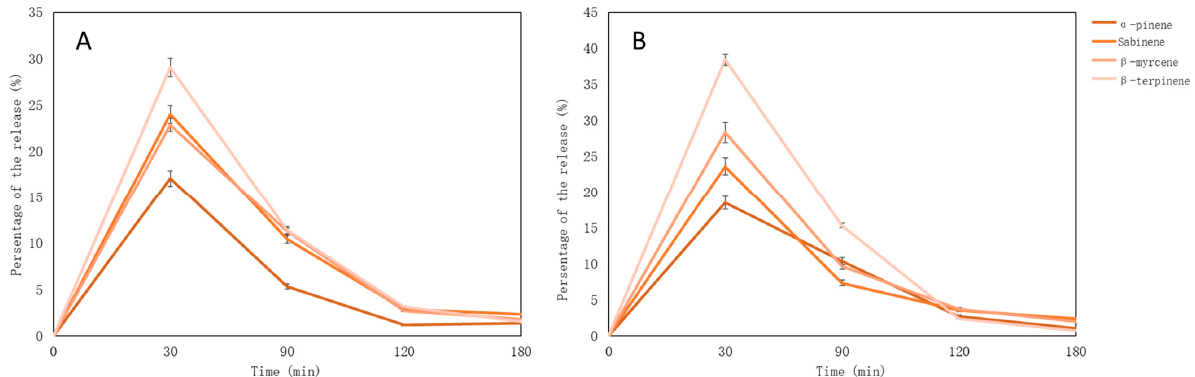
Figure 7. Monoterpenes’ release from nutmeg essential oil-loaded lyophilized microcapsules (%); ( A ) gelatin gel tablets; ( B ) pectin gel